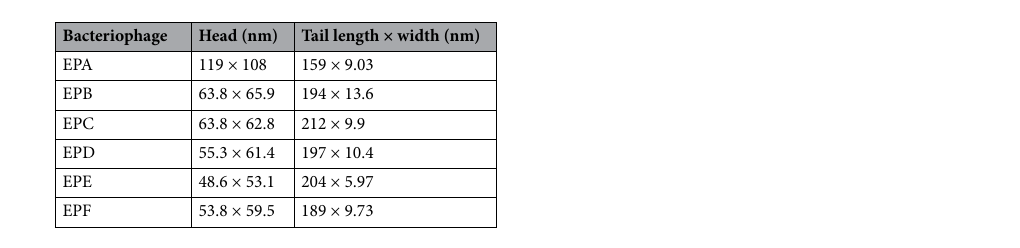
Table 2. Dimensions of the six enterococcal phages (EPA: F) by using transmission electron microscope.